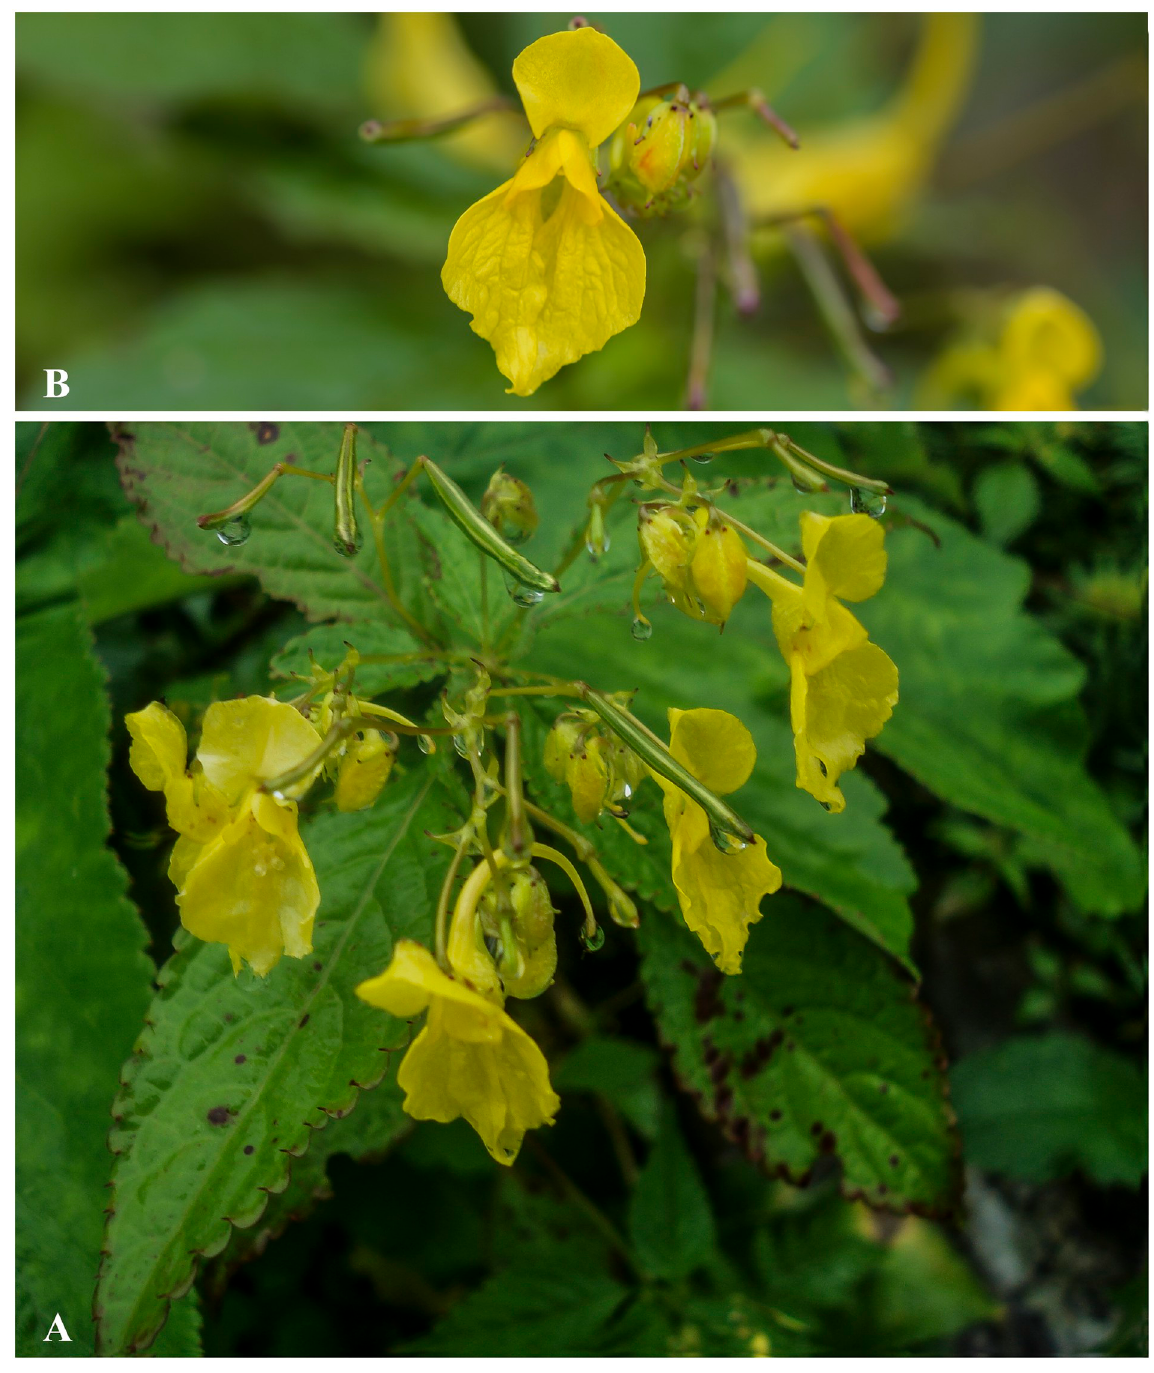
Fig 18. Impatiens laxiflora A. Flowering plant; B. Flower (front view). Photographs by Bhakta Bahadur